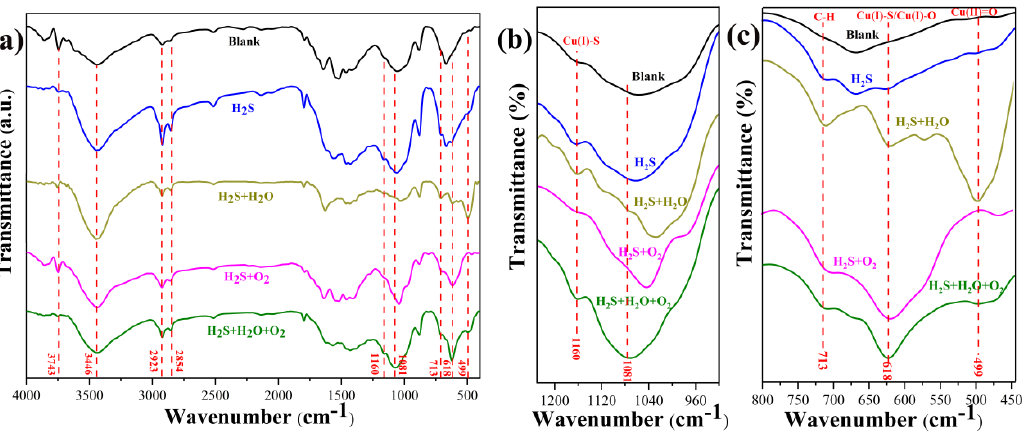
Figure 10. FTIR images of corrosion products on copper powder in different LPG environments: ( a ) FTIR full spectrum, ( b ) FTIR images of 920~1230 cm −1 , ( c ) FTIR images of 445~800 cm −1 .